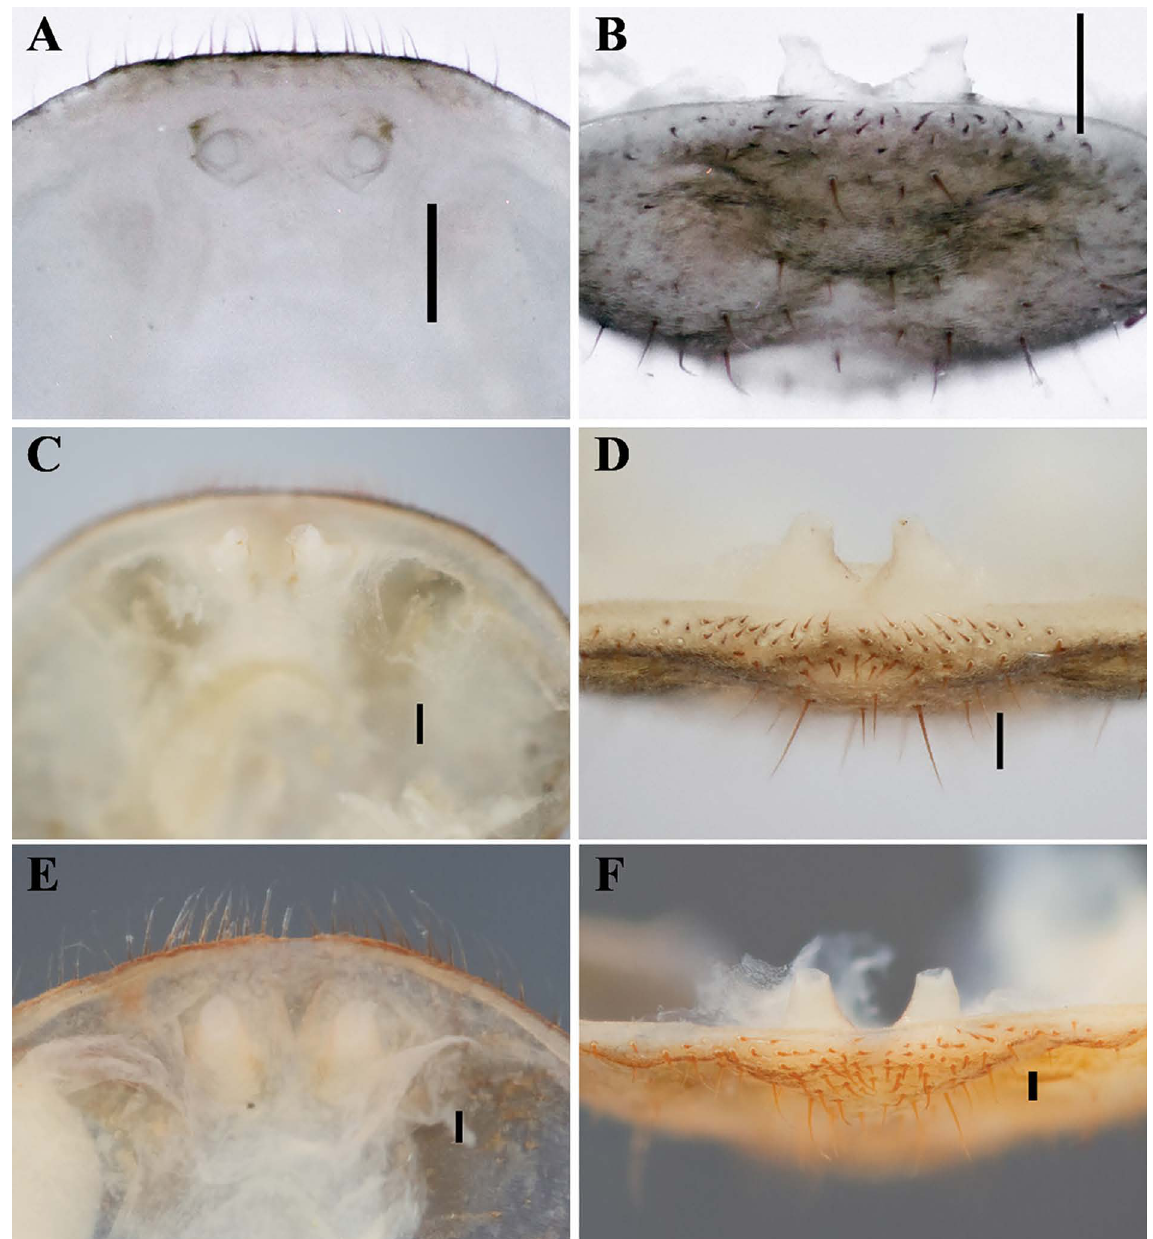
Fig. 6. Charinus Simon, 1892, female gonopods, dorsal (left column) and posterior (right column) views. A–B . Charinus renneri sp. nov. (MNRJ 9198). C–D . Charinus euclidesi sp. nov. (MNRJ 9099). E–F . Charinus carioca sp. nov. (MNRJ 9201). Scale bars: A–D = 0.25 mm; E–F = 0.1